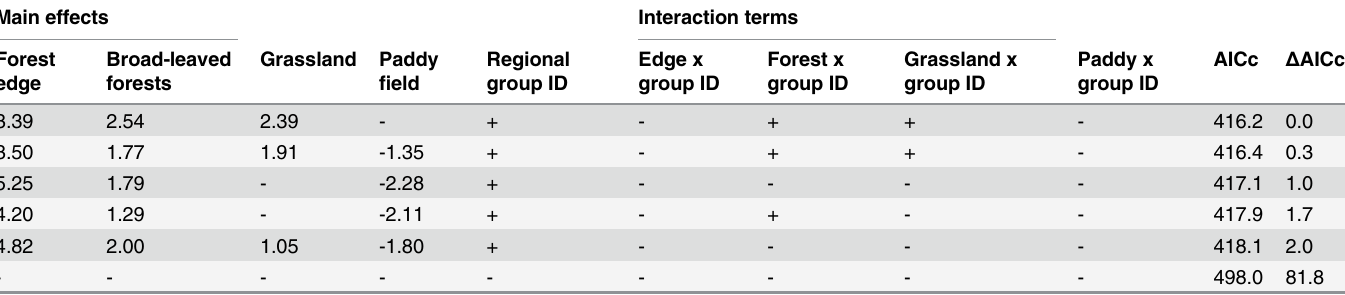
Table 2. Selected models for 5 regional groups to explain relationships between buzzard occurrence and landscape elements.